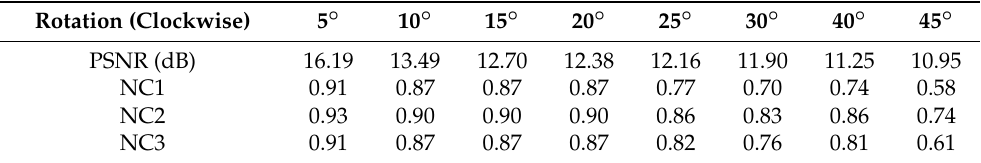
Table 6. Data of rotation attacks.